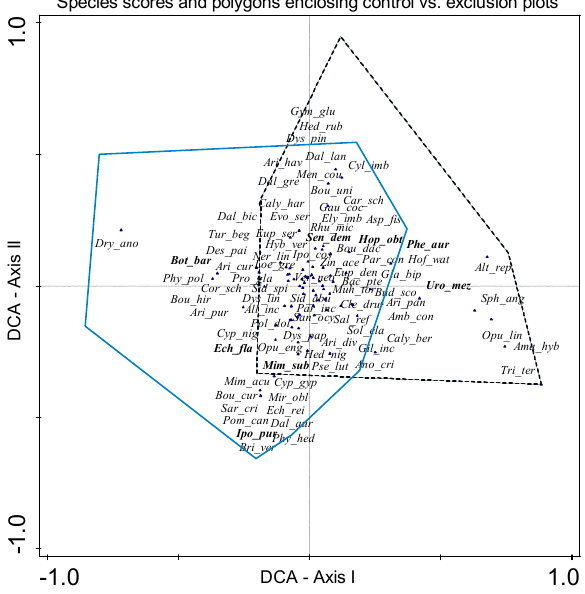
Figure 6. Detrended correspondence analysis axes I and II. Species coordinates and control vs. exclusion plots coordinates. Polygons enclose plots under the same treatment: polygon with a dashed black line for control plots and solid blue line for exclusion plots (species names use the three first letters of the genus, followed by the three first letters of the specific epithet from Appendix A). Eigenvalues for axis I: 0.06, eigenvalue for axis II: 0.05, the cumulative percentage of total inertia for axes I and II: 15.6%.